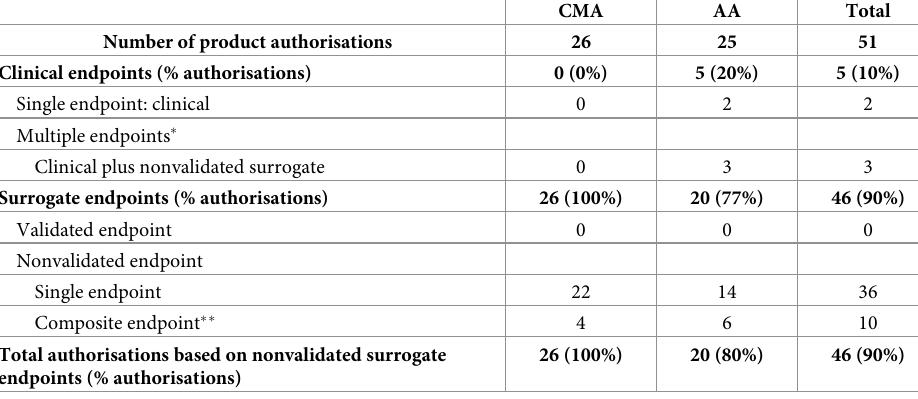
Table 3. Numbers of products granted CMA and AA based on clinical and surrogate